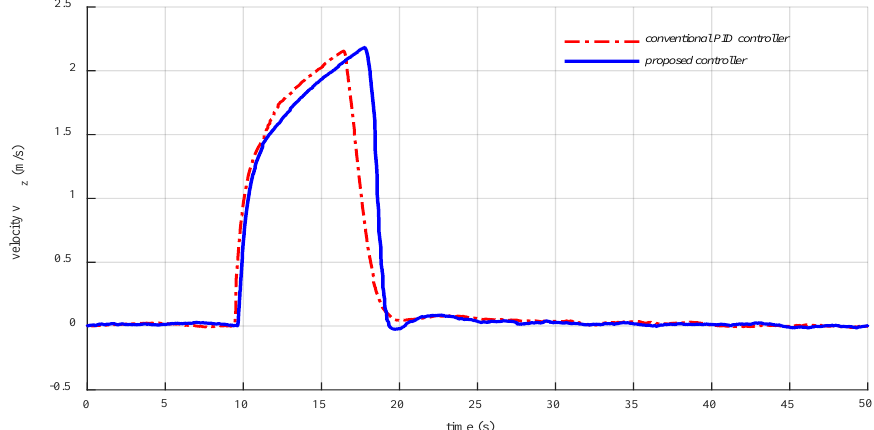
Figure 15. Comparison of the experimental vertical velocity performance between our new controller and a conventional PID controller.